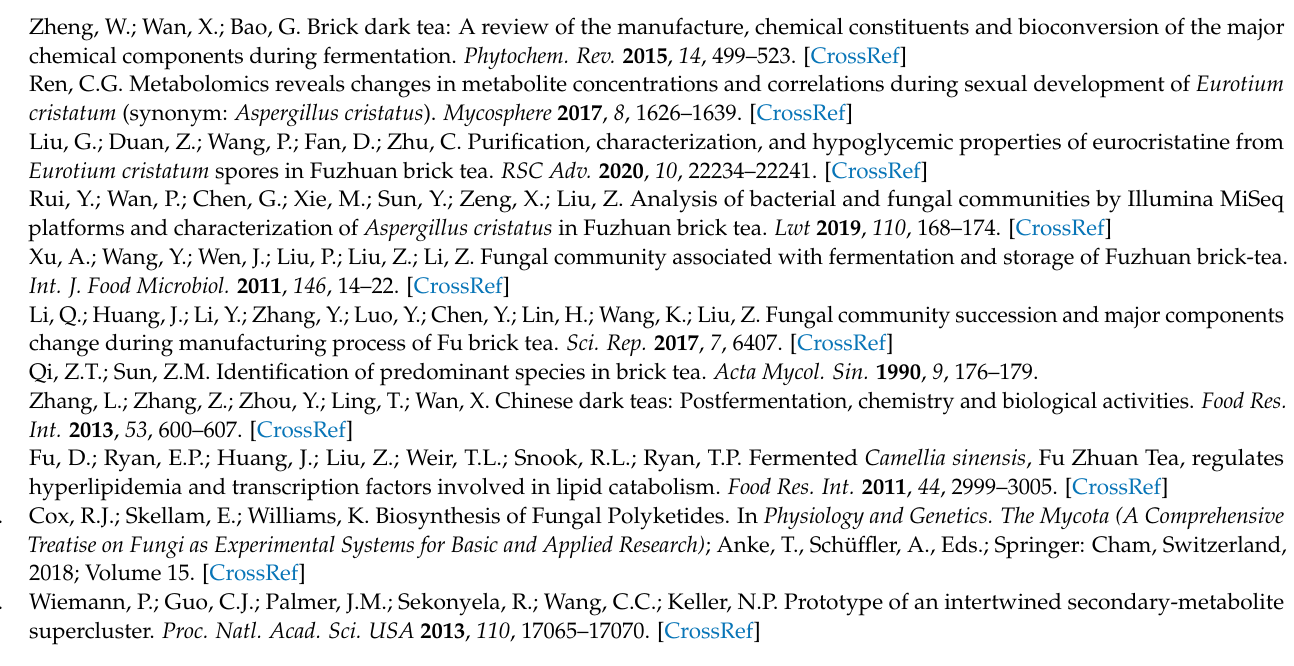
E1 genome, Figure S2: Confirmation of the taxonomic classification of Eurotium cristatum E1, Figure S3: Real-time RT-PCR analysis of the PKS genes in Eurotium cristatum E1, Figure S4: UPLC analysis of Eurotium cristatum E1 extracts, Figure S5: UPLC-MS analysis of Eurotium cristatum E1 extracts, Figure S6: ESIMS spectra in negative mode of flavoglaucin and its derivatives (1–6), citreorosein (7), emodin (8), physion (9) and echinulin (10), Figure S7: The number of PKS genes in some sequenced Aspergillus species, Table S1: Strains and accession information of genes used for phylogenetic tree construction, Table S2: Primers used for qRT-PCR, Table S3: Analysis of A2490 gene cluster in Eurotium cristatum E1, Table S4: Analysis of A7192 gene cluster in Eurotium cristatum